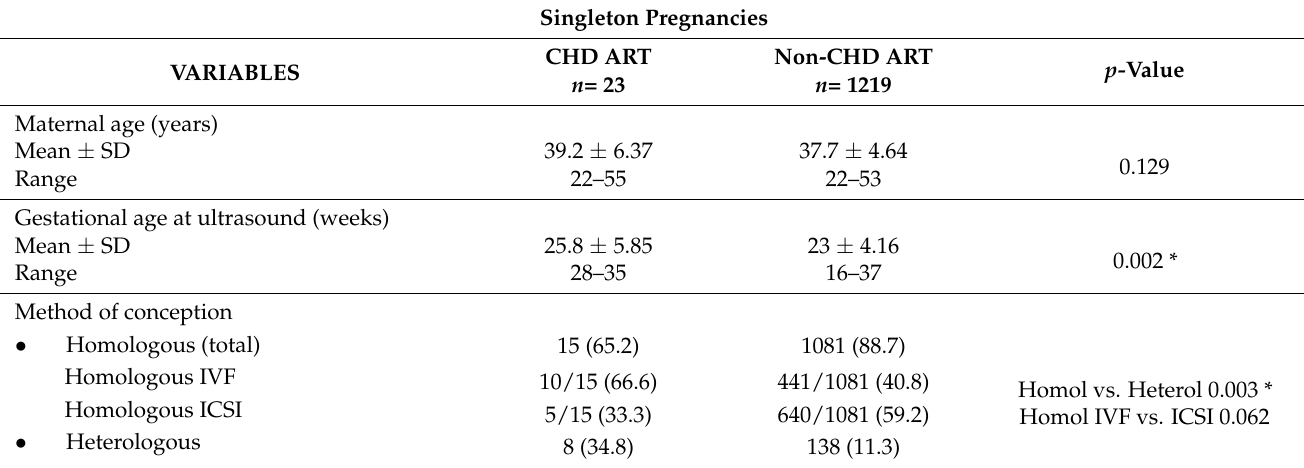
Table 2. Comparison of variables between the two study groups (CHD-ART and non-CHD-ART) in singleton and multiple